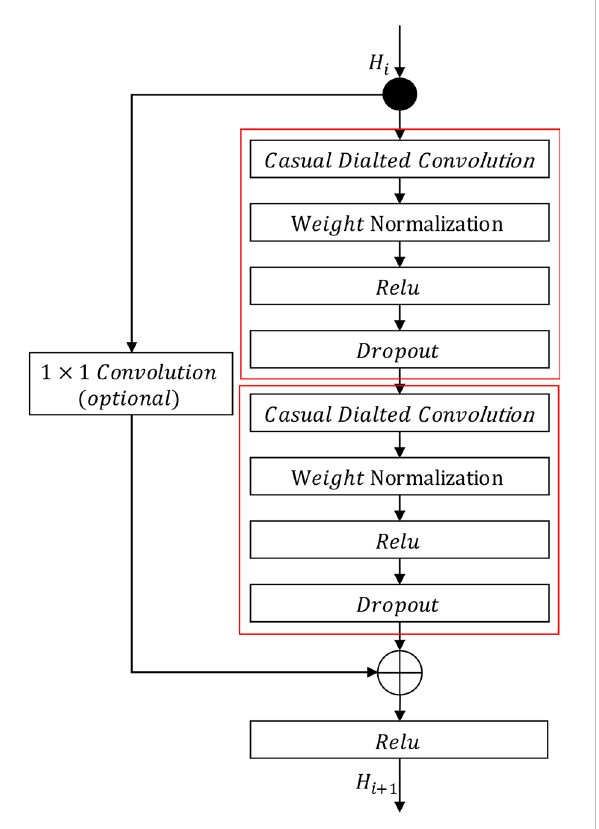
FIGURE 3 Causal dilated block. The residual mapping function is represented by the two red boxes, and the identity mapping function is on the left. The symbol ⊕ denotes element-wise addition.